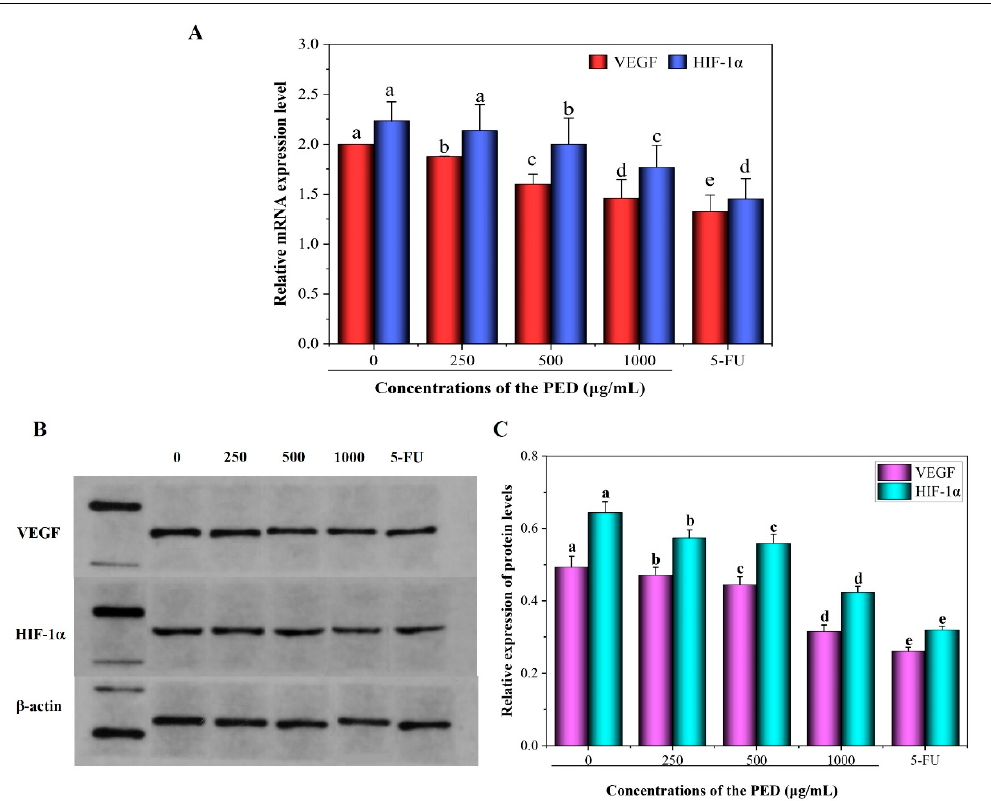
Figure 11. Effect of PED on the expression levels of HIF-1 α and VEGF. ( A ): the mRNA expression levels; ( B , C ): the protein expression levels. The β -actin was indicated the internal control. Different lowercase letters indicate significant differences ( p < 0.05).